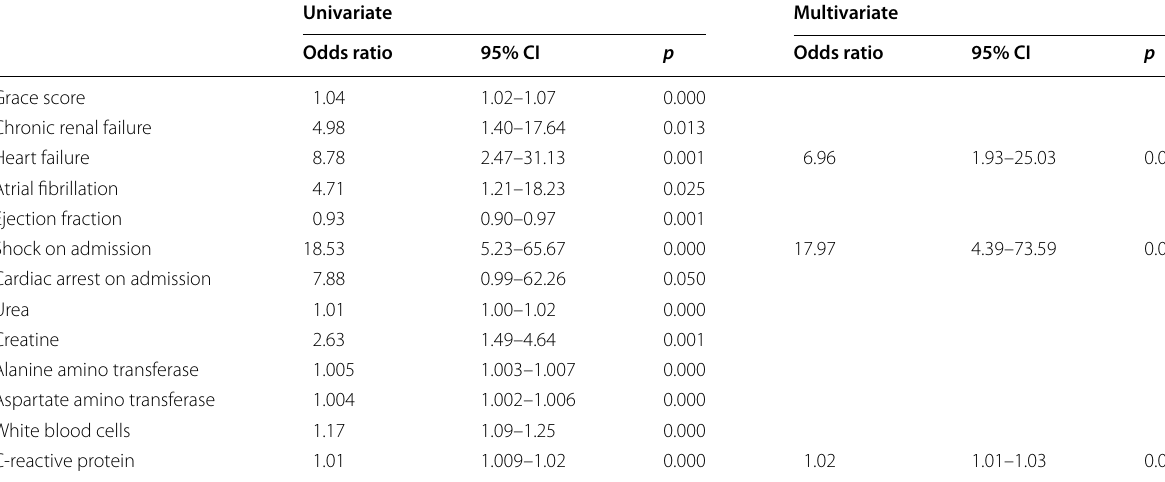
Table 3 In-hospital mortality univariate and multivariate regression analysis Univariate Multivariate